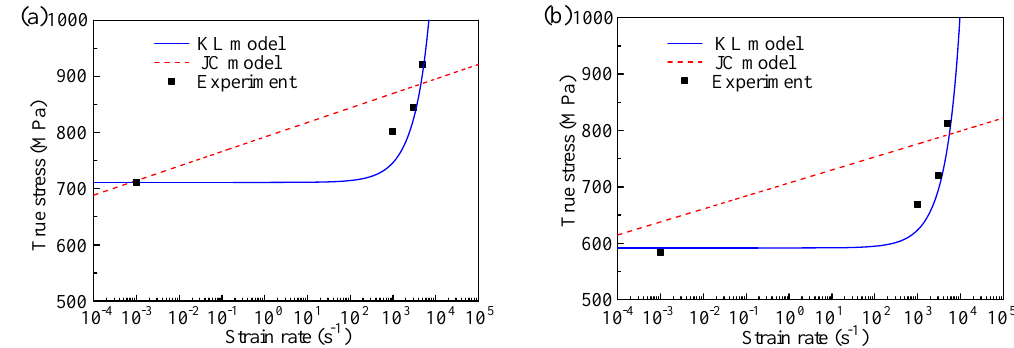
Figure 11. Comparison of strain rate effect by JC and KL model at plastic strain 0.06 for different temperature: ( a ) 20 °C, and ( b ) 200 °C.